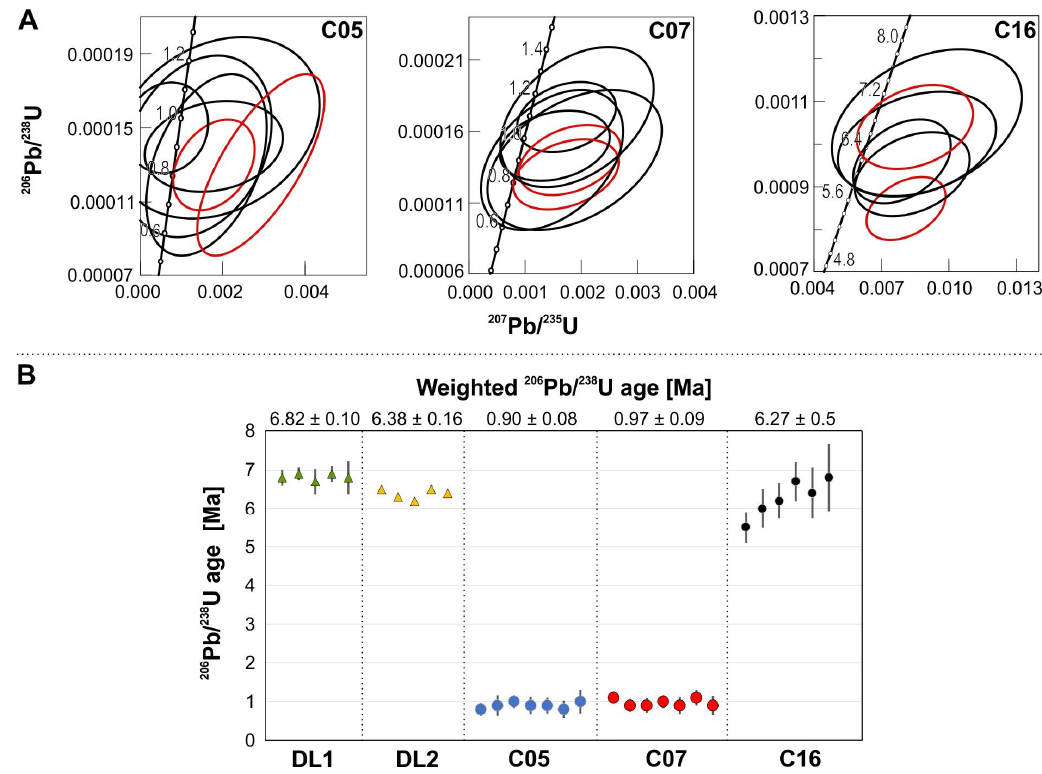
Figure 9. Summary of U-Pb geochronology data obtained by LA-ICP-MS (see details in Tables S2 and S3). ( A ) Representative concordia plots of samples C05, C07, and C16. Ellipses give a 2σ error, and red ellipses correspond to measurement spots placed in the core region of single crystals. ( B ) 206 Pb/ 238 U ages of the samples analyzed with the mean weighted age given for each sample. Error bars